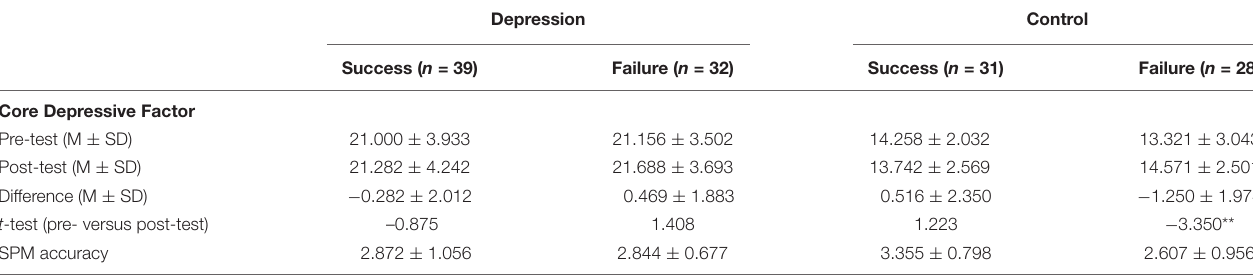
TABLE 3 | Pre- and post-test depressed emotion scores and SPM accuracy ratings.